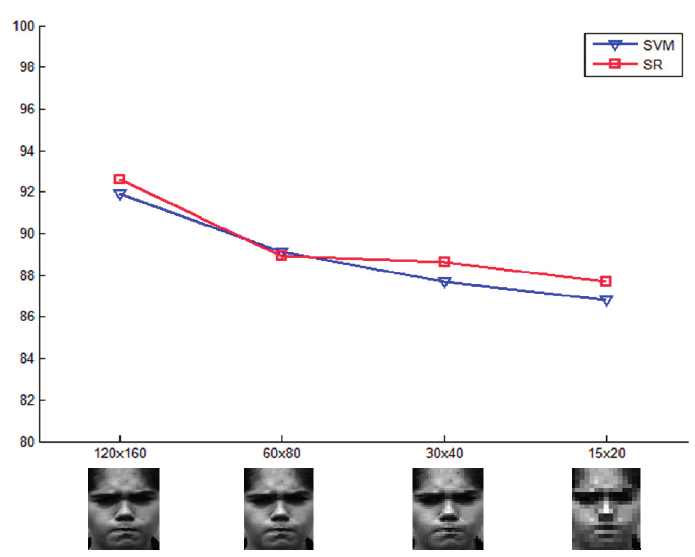
Figure 7. Comparisons on image resolutions between SR and SVM.